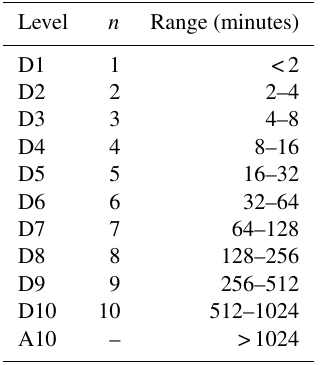
Table 2. Decomposition levels and the corresponding periods range for each level used in the wavelet decomposition